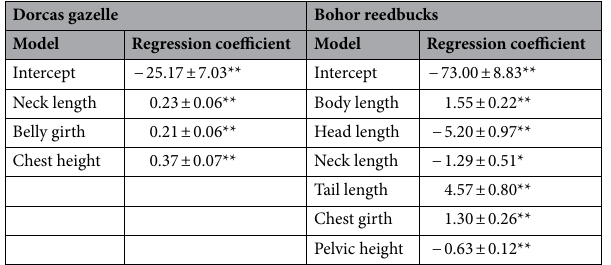
Table 9. Regression coefficients (± standard errors) of the best two models predicting body weight from body measurements of Dorcas gazelle and Bohor reedbucks. *Significant at P < 0.05. **Significant at P > 0.01.